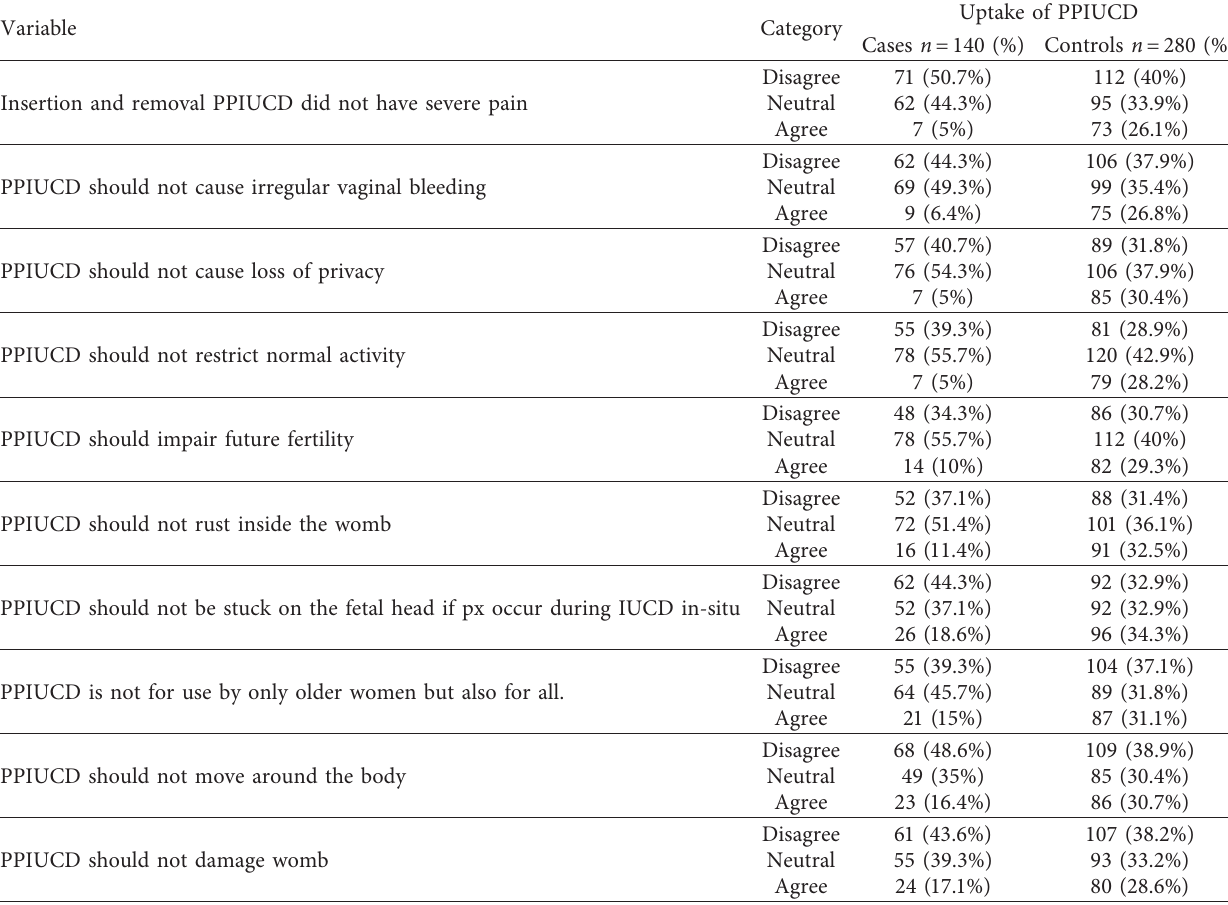
Table 5: Participants attitudes towards PPIUCD among women who gave birth at public hospitals of South Gondar, Ethiopia, 2019 ( n � 140 cases and 280